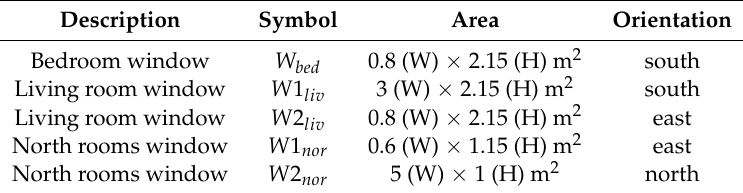
Table 3. Description of the windows used in the studied